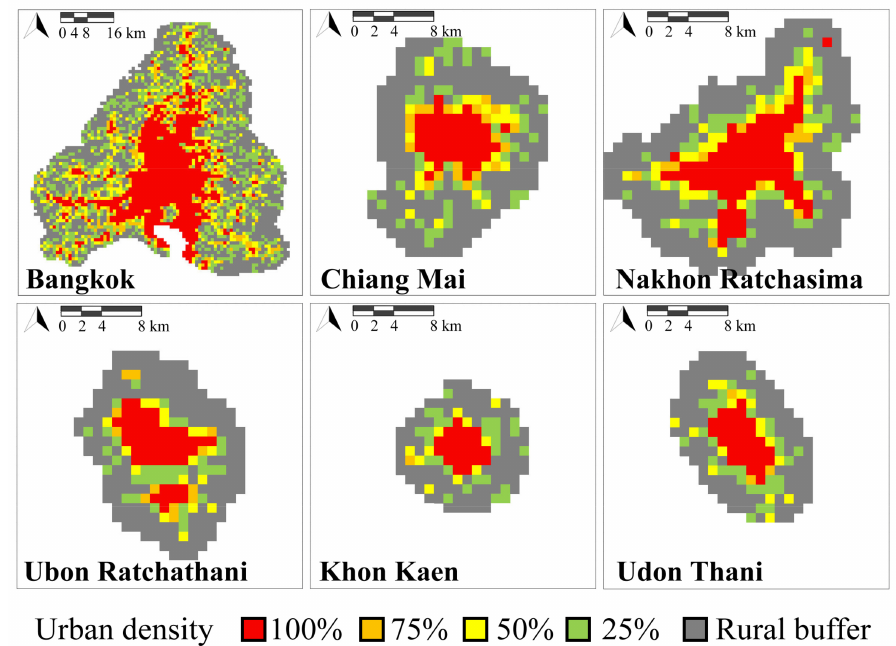
Figure 3. Urban and rural category maps from MODIS MCD12Q1 product of 2013 for the six cities (1 km pixel size) used for the computation of the reference rural land surface temperature (LST RUR ) (rural